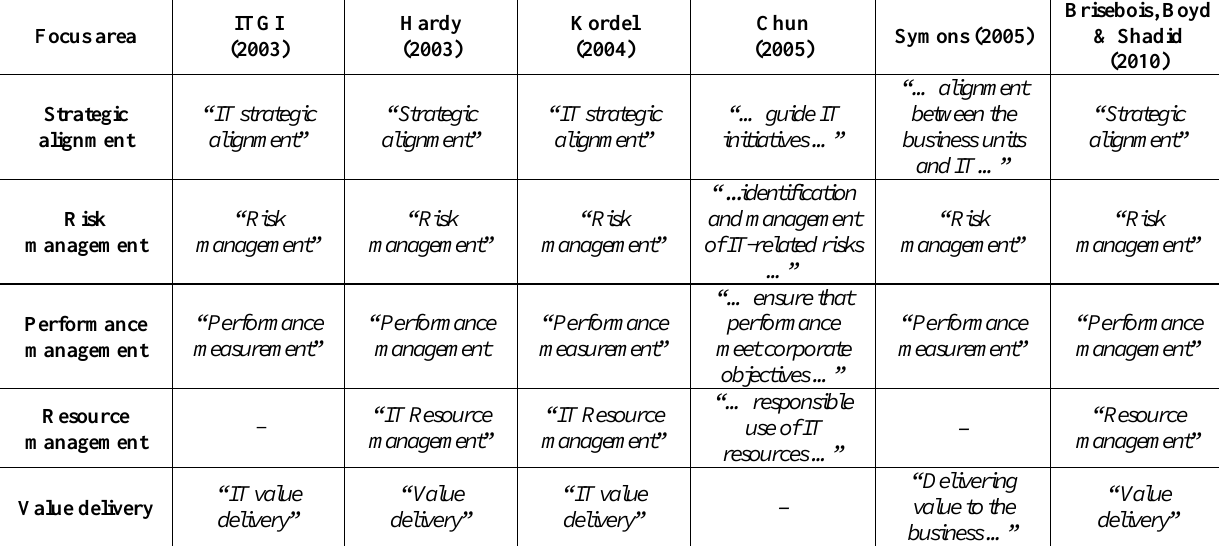
Table 3: IT Governance focus areas and key concepts emphasized by authors Focus